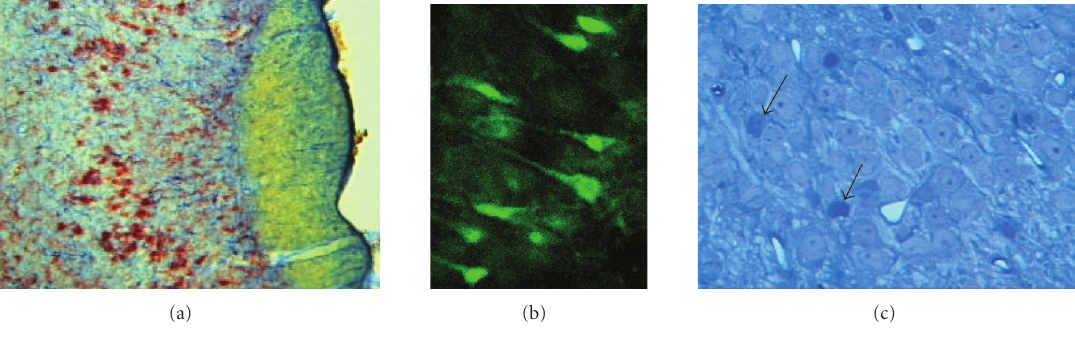
Figure 3: Morphological changes in the piriform cortex. Maximal microglial activation was present 7 days after moderate head injury. The microglial cells are stained with OX-42 and astrocytic cells are stained with ED-1. The depicted area is the piriform cortex, a basal structure in the rat brain (a). Neurodegeneration is shown in section (b), using fluorojade-stained vibratome sections adjacent to the ones shown in section (a). The damaged neurons can be recognized by a brightly fluorescent signal and were most numerous at 1 week after a moderate CHI. A detailed 2-micron thick epon image of the piriform cortex is shown in section (c), the arrows indicate neurons in an early stage of pycnotic